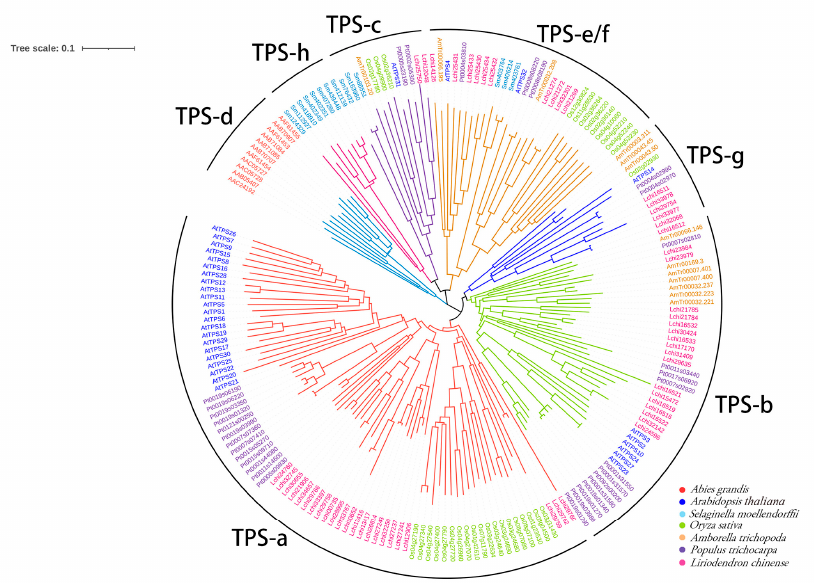
Figure 1. Phylogenetic analysis of Terpen synthase in P. trichocarpa , S. Moellendorffii , A. thaliana , A. trichopoda , A. grandi , O. sativa , and L. chinense .